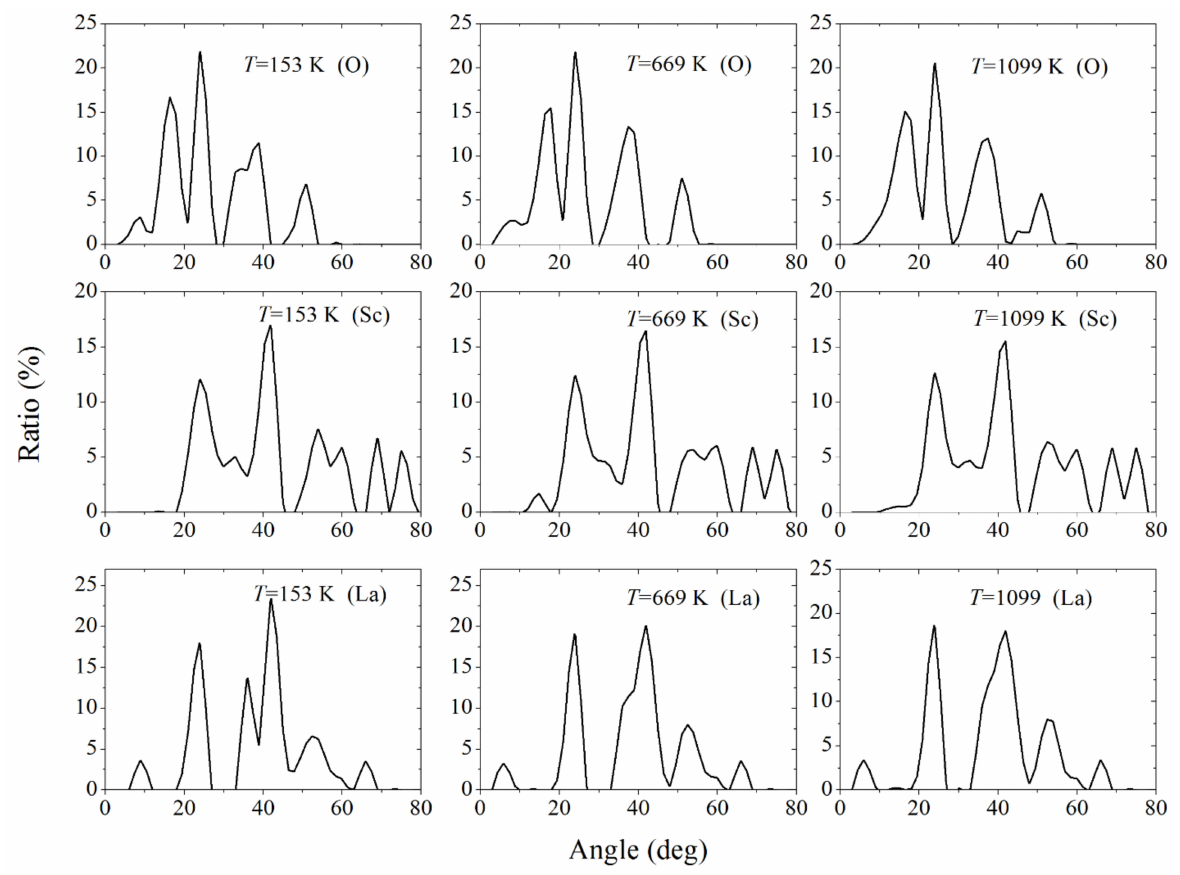
Figure 13. Angular distributions of the nearest geometrical neighbors of the proton, obtained during its migration in the LaScO 3 crystal lattice in the presence of an electric field of strength E = 4.9 × 10 10 V/m (series 7–9) at different temperatures; the initial position of the proton corresponds to position 3 (as classified in Table 1) and its initial velocity is 0; the captions within of the figure reflect the temperature and the type of neighbors (in